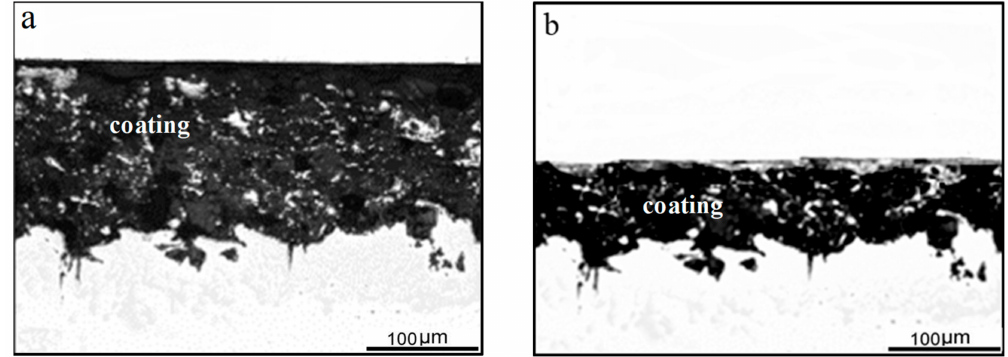
Figure 8. Metallographic microstructure of coatings: ( a ) After 300,000 cycles and ( b ) after 400,000